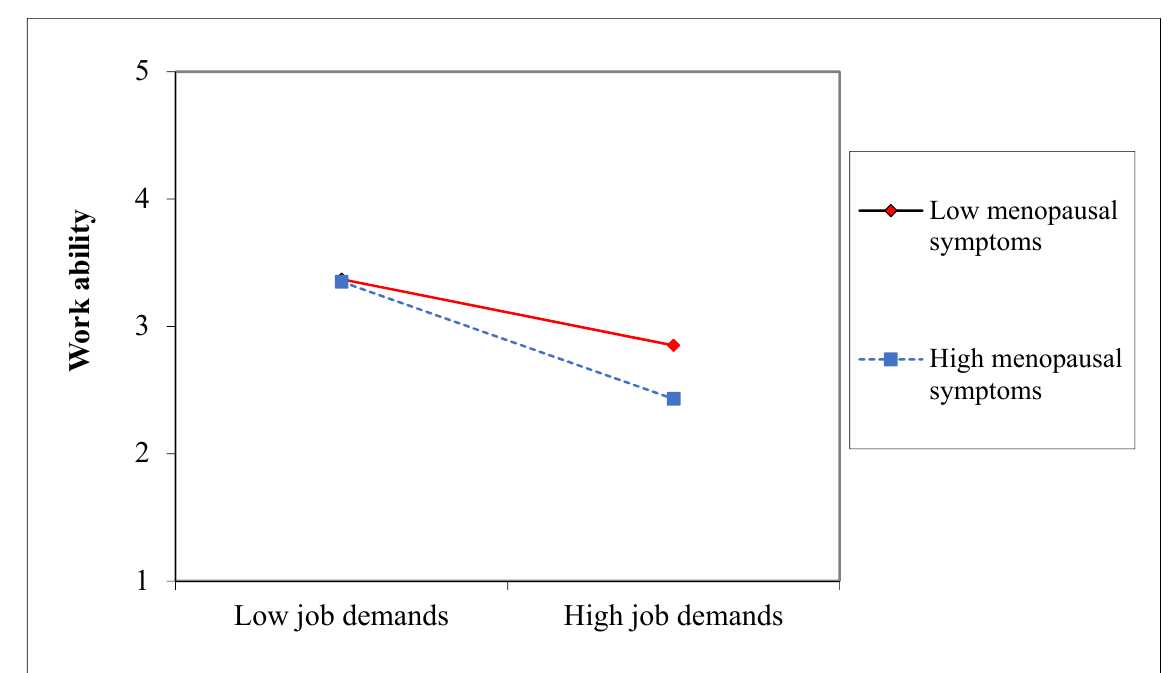
Figure 2. The moderating effect of menopausal symptoms in the relationship between job demands and work ability.